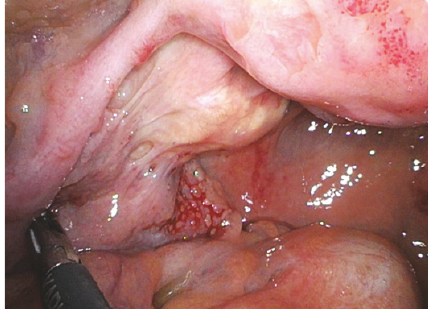
Figure 2: Left ovary and Fallopian tubes with reddish-yellow deposits.